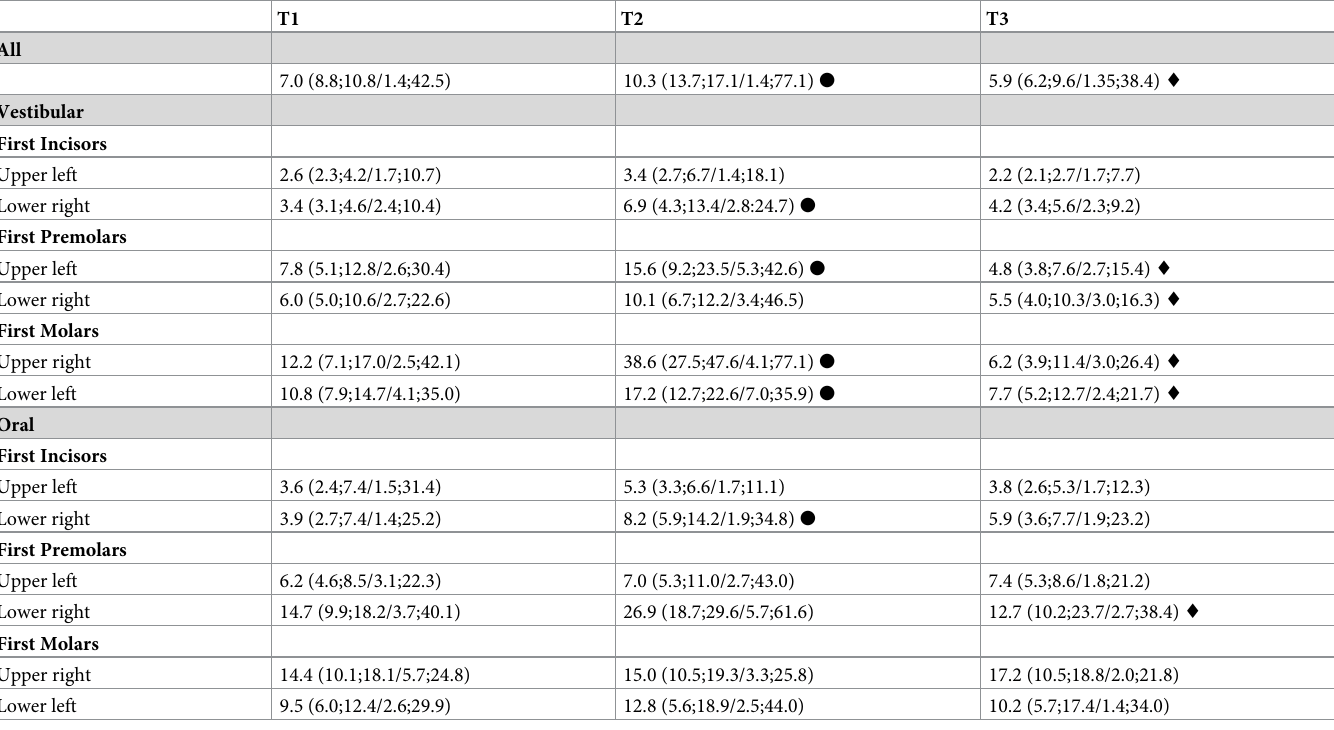
Table 1. Overall and site-specific P%S values (median (95% confidence interval/min;max)) obtained from images from the 3D-intraoral-scan at T1 (baseline), T2 (after 72 h without oral hygiene) and T3 (after